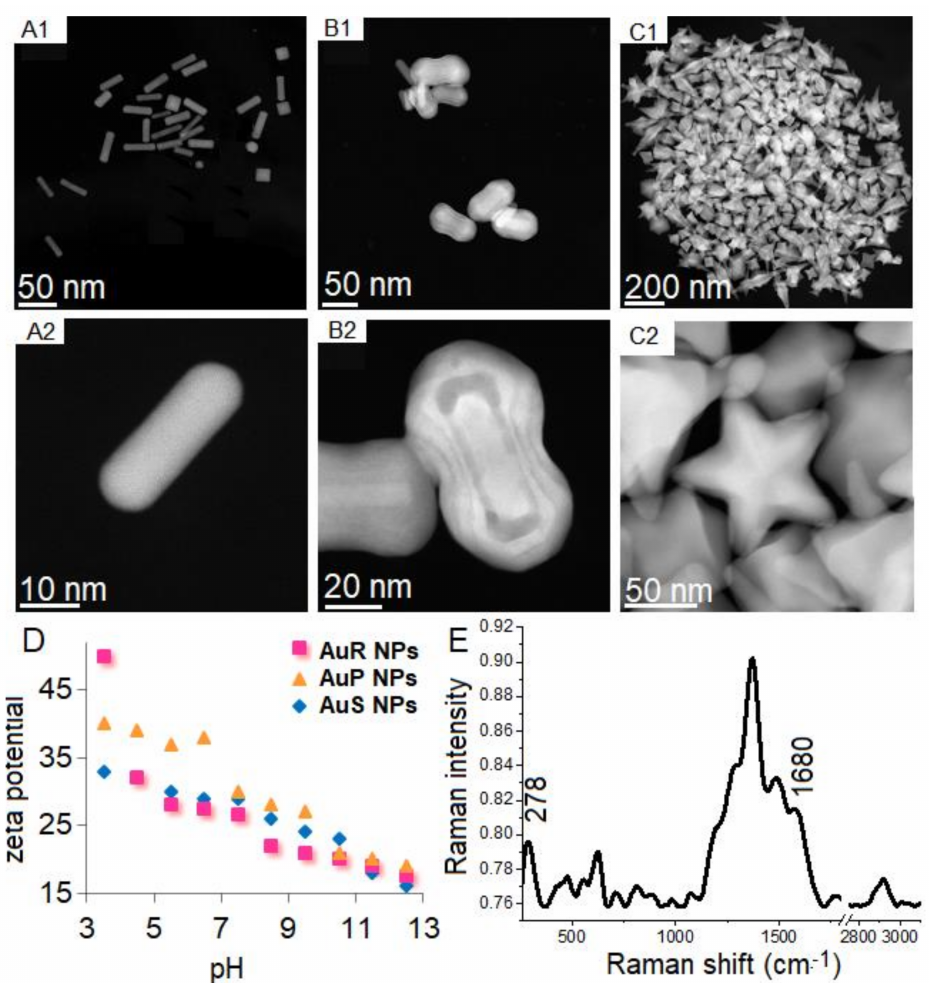
Figure 1. HAADF-STEM over view (1) and magnified (2) images of AuR ( A ), AuP ( B ), and AuS ( C ). Zeta potential values of synthesized AuR, AuP, and AuS ( D ). Representative FT-Raman spectrum showing the chemical mechanism of ceragenins CSA-13 immobilized on the AuP NPs surface ( E